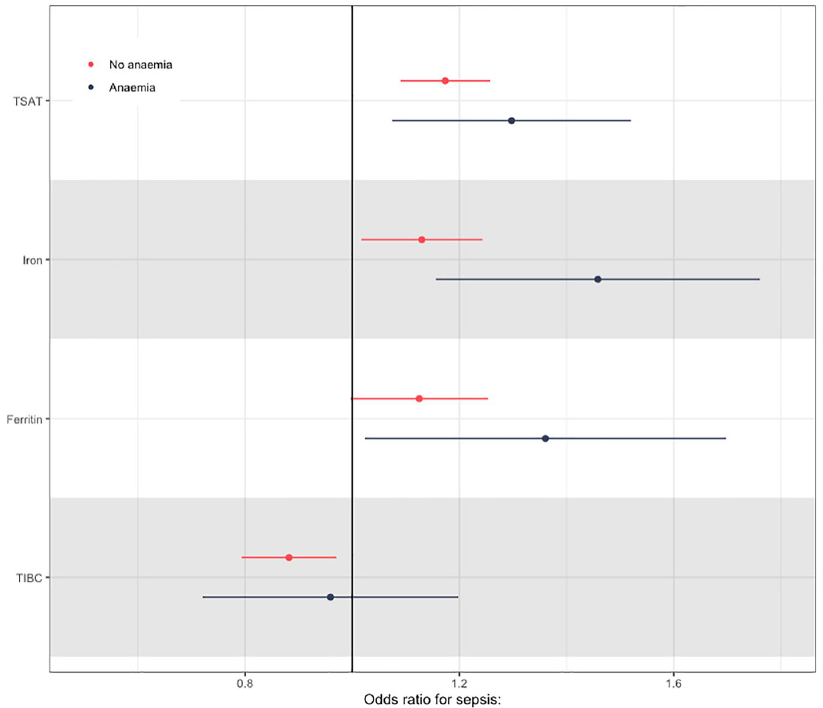
Figure 6. Odds ratios for each SD increase in each PRS for sepsis in anaemic and non-anaemic population in UK